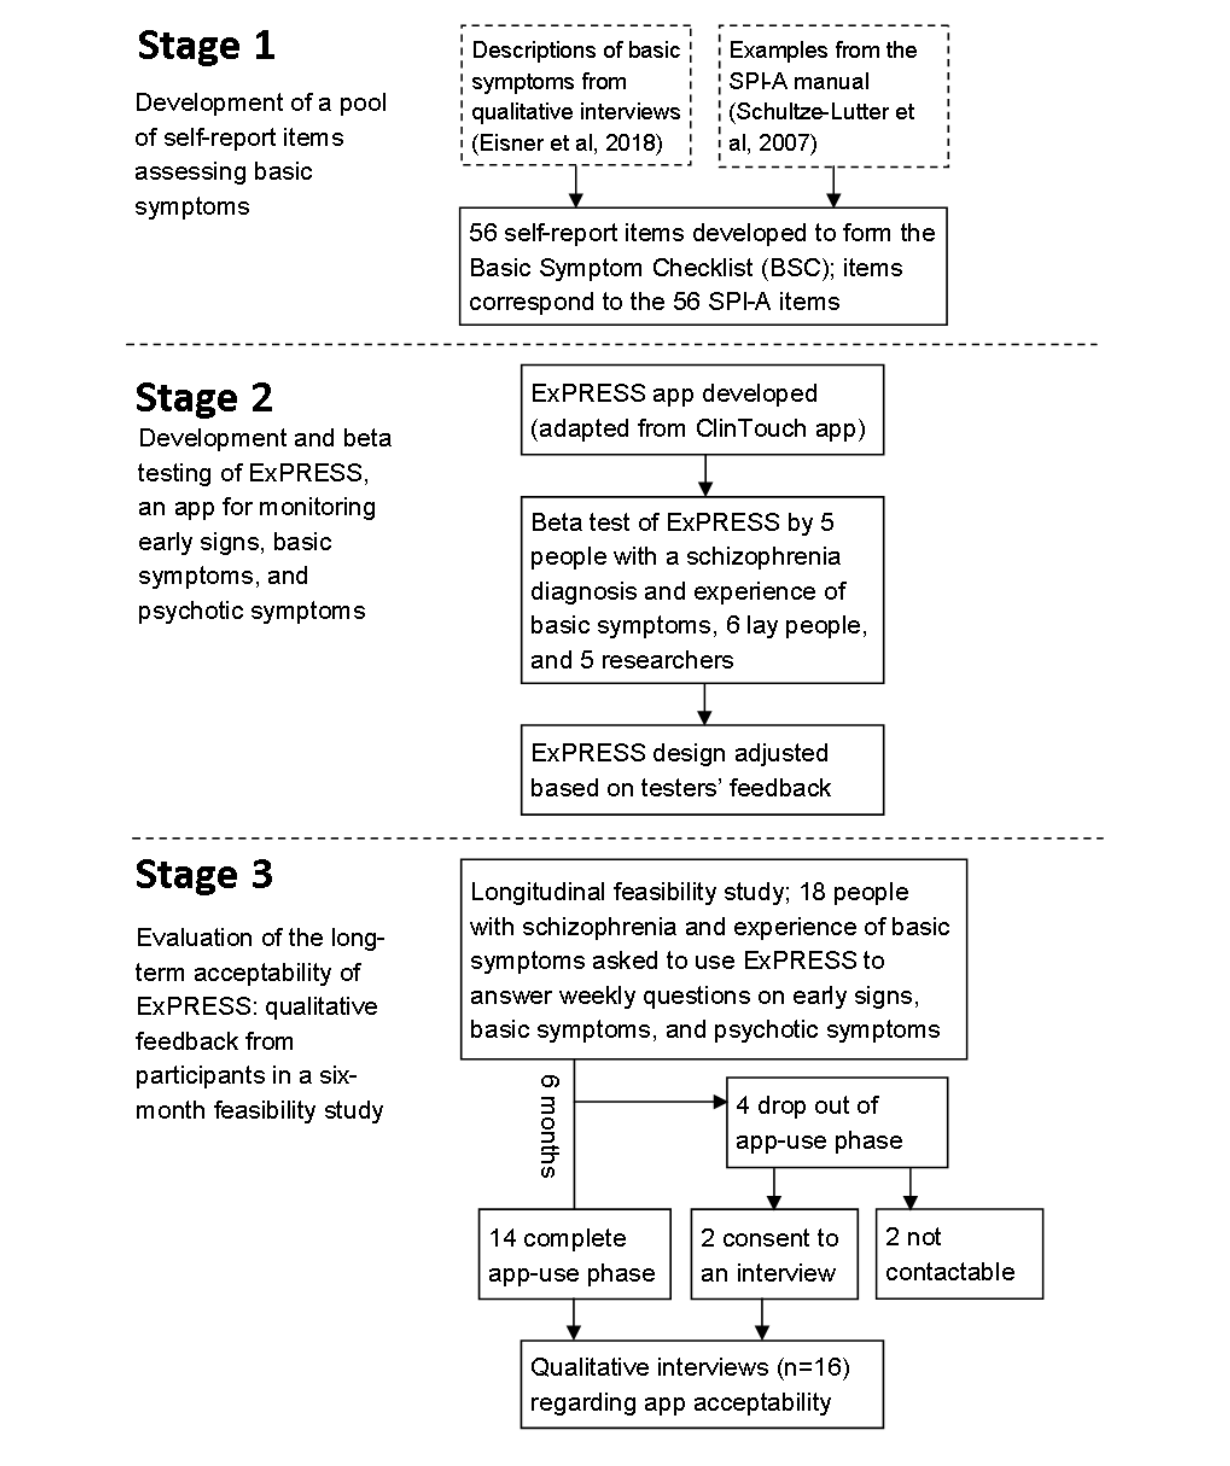
Figure 1. Flow diagram of study design. BSC: Basic Symptom Checklist; SPI-A: Schizophrenia Proneness Instrument, Adult